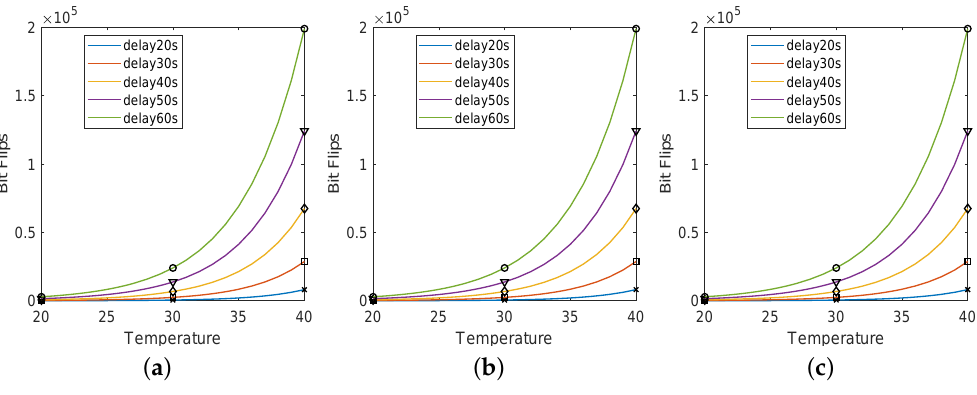
Figure 7. Relation between the temperature, decay time and number of bit flips measured on three Raspberry Pi B+ boards. ( a ) Test results of RPi1. ( b ) Test results of Rpi2. ( c ) Test results of